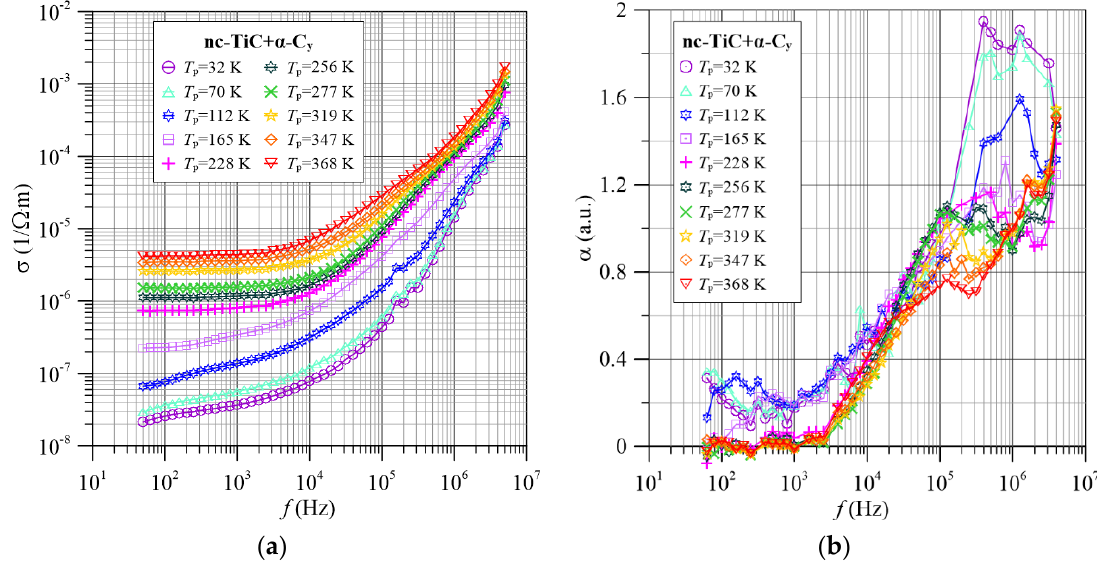
Figure 4. Frequency dependence of conductivity ( a ) and frequency factor α ( f ) ( b ) for selected measurement temperatures for the nc-TiC+ α -C y nanocomposite.